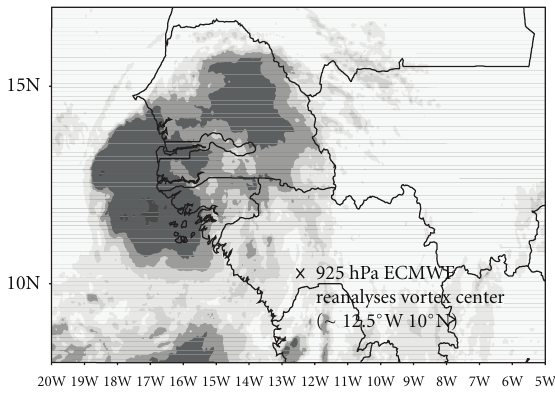
Figure 6: (a) Depiction of TRMM globally merged IR cloud top temperatures (K) on 11 September 2006 for 8 ◦ N to 17 ◦ N and 20 ◦ W to 5 ◦ W for 0000 UTC. The X denotes the 0000 UTC 925 hPa ECMWF Reanalyses Vortex Center. (b) Depiction of TRMM MERG IR cloud top temperatures (K) on 11 September 2006 for 8 ◦ N to 17 ◦ N and 20 ◦ W to 5 ◦ W for 0200 UTC. (c) Depiction of TRMM MERG IR cloud top temperatures (K) on 11 September 2006 for 8 ◦ N to 17 ◦ N and 20 ◦ W to 5 ◦ W for 0400 UTC. (d) Depiction of TRMM MERG IR cloud top temperatures (K) on 11 September 2006 for 8 ◦ N to 17 ◦ N and 20 ◦ W to 5 ◦ W for 0600 UTC. The X denotes the 0600UTC 925 hPa ECMWF Reanalyses Vortex Center. (e) Depiction of TRMM globally merged IR cloud top temperatures (K) on 11 September 2006 for 8 ◦ N to 17 ◦ N and 20 ◦ W to 5 ◦ W for 0800 UTC. (f) Depiction of TRMM MERG IR cloud top temperatures (K) on 11 September 2006 for 8 ◦ N to 17 ◦ N and 20 ◦ W to 5 ◦ W for 1000 UTC. (g) Depiction of TRMM MERG IR cloud top temperatures (K) on 11 September 2006 for 8 ◦ N to 17 ◦ N and 20 ◦ W to 5 ◦ W for 1200 UTC. The X denotes the 1200 UTC 925 hPa ECMWF Reanalyses Vortex